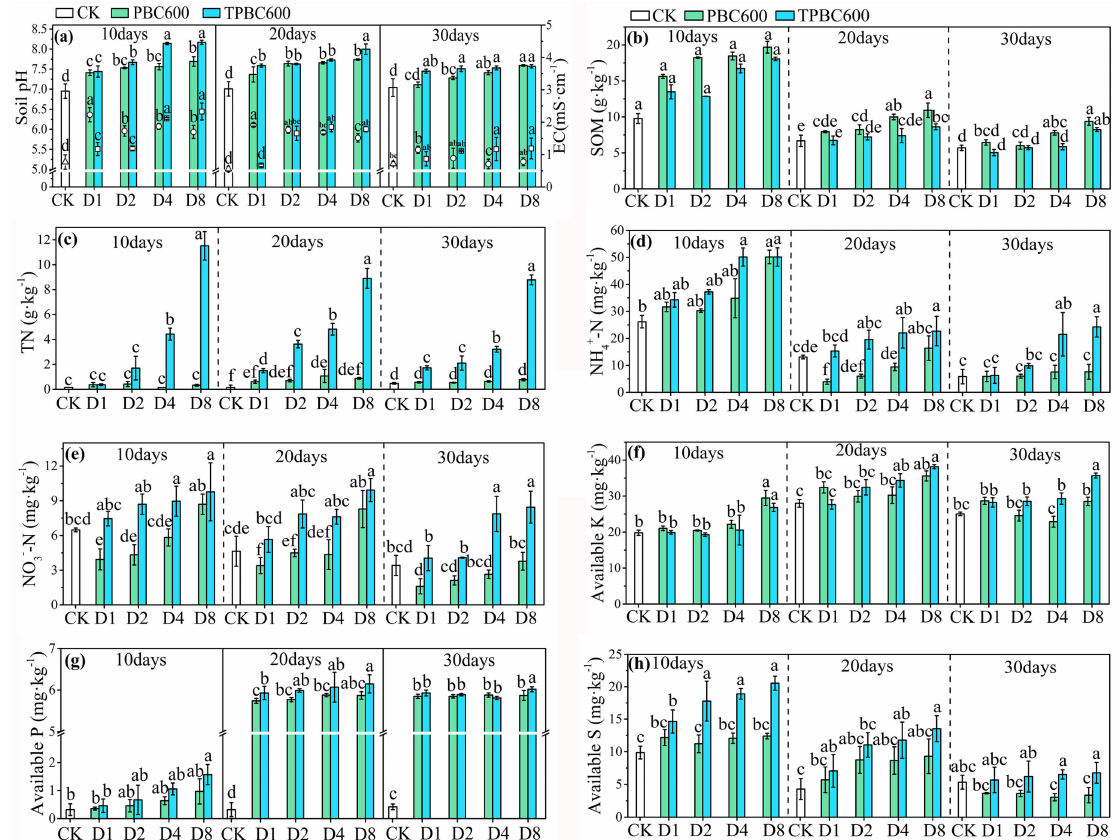
Figure 1. E ff ects of poplar-bark biochar (PBC600) and thiourea-modified poplar-bark biochar (TPBC600) treatments on pH, electrical conductivity (EC) ( a ), organic matter (SOM) ( b ), total nitrogen − N) ( d ), nitrate nitrogen (NO − − N) ( e ), available potassium(AK) (TN) ( c ), ammonium nitrogen (NH + 3 4 ( f ), available phosphorus (AP) ( g ), and available sulfur (AS) ( h ) in soil. The triangles, circles, and squares in Figure 1a represent the EC values of CK, PBC600, and TPBC600, respectively. The data and error bars represent the mean values and standard deviations. Di ff erent letters indicate that the average values under di ff erent sampling conditions were significantly di ff erent ( p <